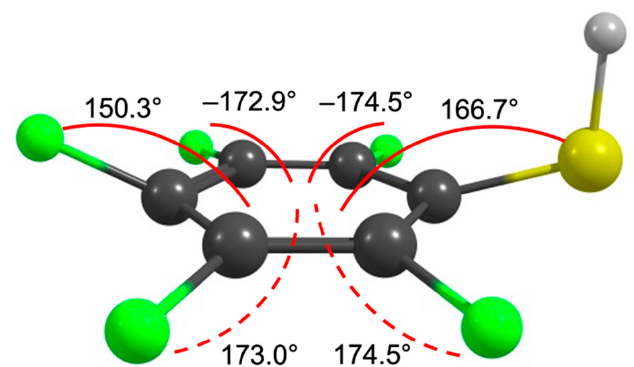
Figure 5. Relaxed geometry of the PFTP anion optimized at the B3LYP D3BJ/aug-cc-pVTZ level of theory. The angles shown in the figure are the angles between the out-of-plane C–F and C–S bonds and the plane of the ring.